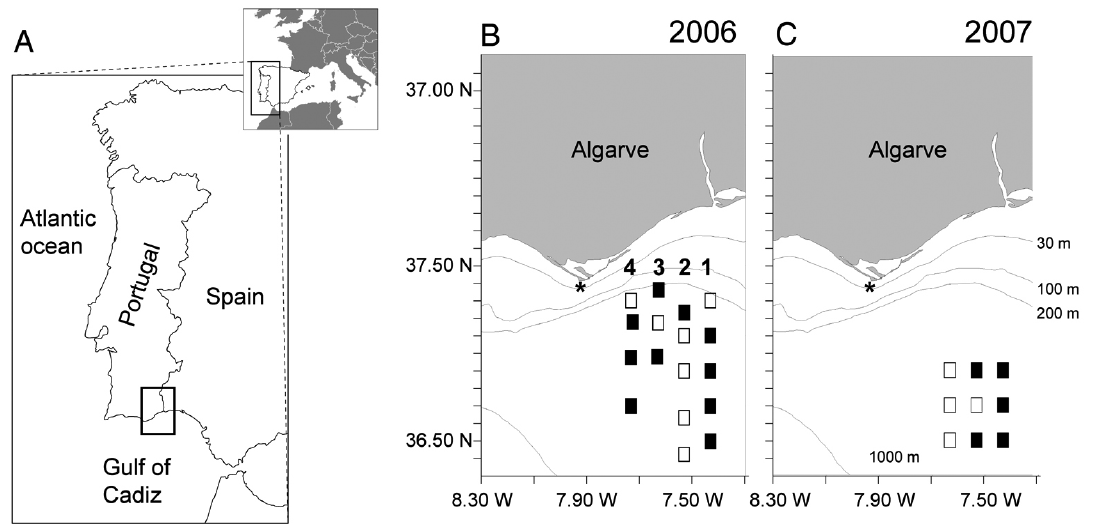
Fig. 1. – Map showing Europe and Portugal (A) and the locations of sampling sites in 2006 (B) and 2007 (C). B, sampling started on January 29, 2006 at 12:00 and ended on February 5, 2006 at 16:30. C, sampling started at station 1 on January 24, 2007 at 15:00 and ended on January 31, 2007 at 11:15. Black and white squares indicate night and day sampling, respectively; *indicates the location of Cape St